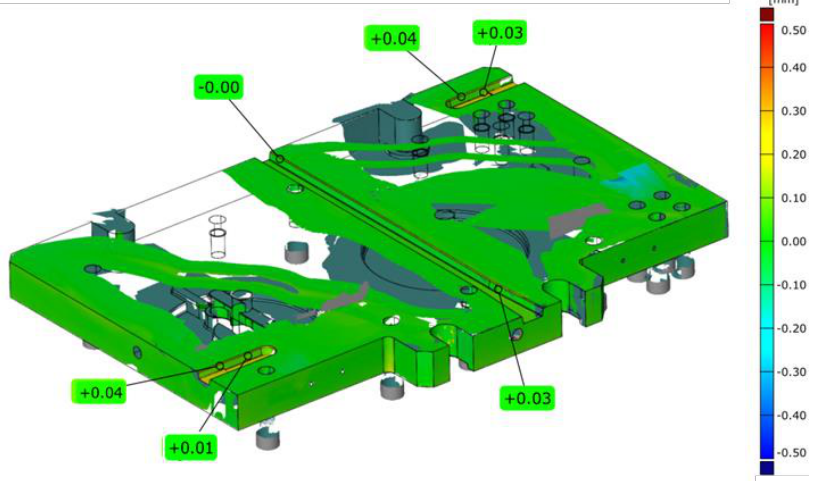
Figure 4. An example of measurements with view of colour deviation map of 3D scans of lower cassette.